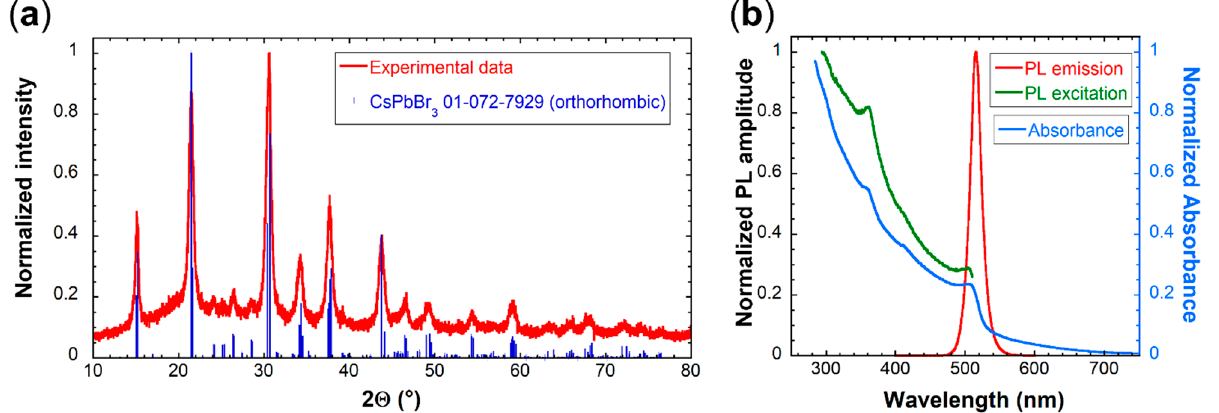
Figure 1. ( a ) XRPD pattern (red line) of synthesized material used for spin-coating. Identified phase according to ICDD PDF-2 database was orthorhombic CsPbBr 3 no. 01-072-7929 (blue lines). ( b ) PL emission (red line), excitation (green line), and absorption (blue line) spectra of synthesized solution used for spin-coating.